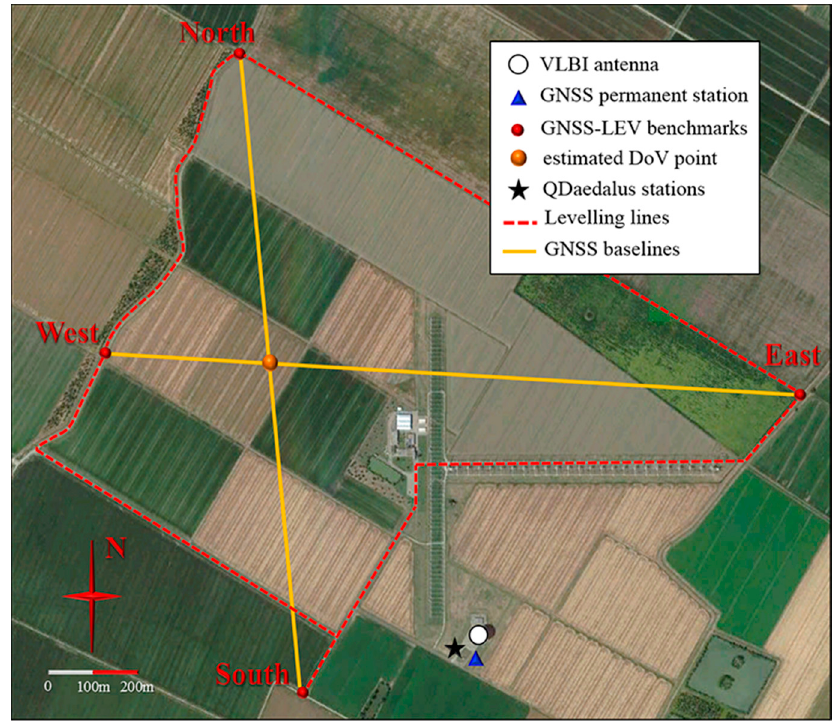
Figure 1. Area of IRA-INAF observatory of Medicina (Northern Italy) (satellite image courtesy of Google Earth ® ).